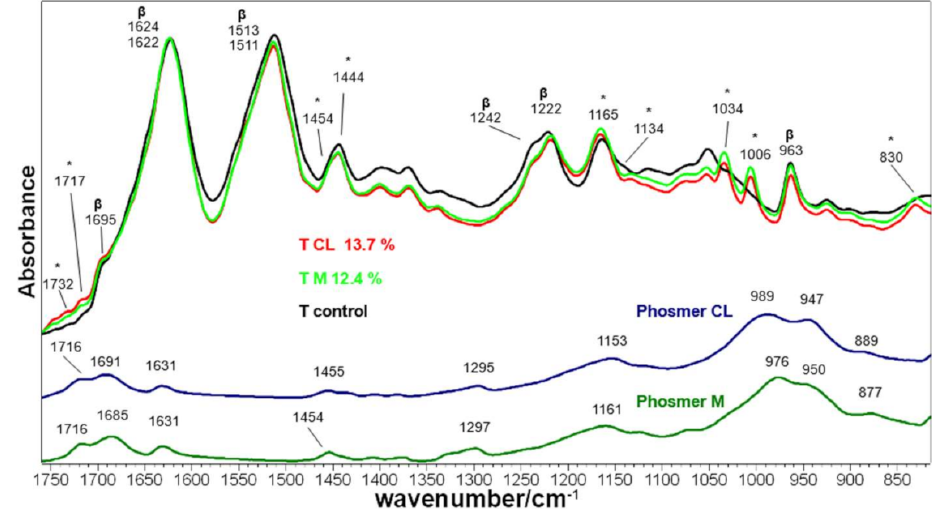
Figure 10. IR spectra of Tussah silk fibroin fabrics before (control) and after grafting with phosmer CL (weight gain 13.7%) and M (weight gain 12.4%). The spectra are normalized to the Amide I band. The spectra of phosmers CL and M are reported for comparison; the main bands that in the grafted samples strengthened due to their contribution are indicated with * (see Supplementary Material for assignments). The main bands assignable to β -sheet ( β ) conformation are